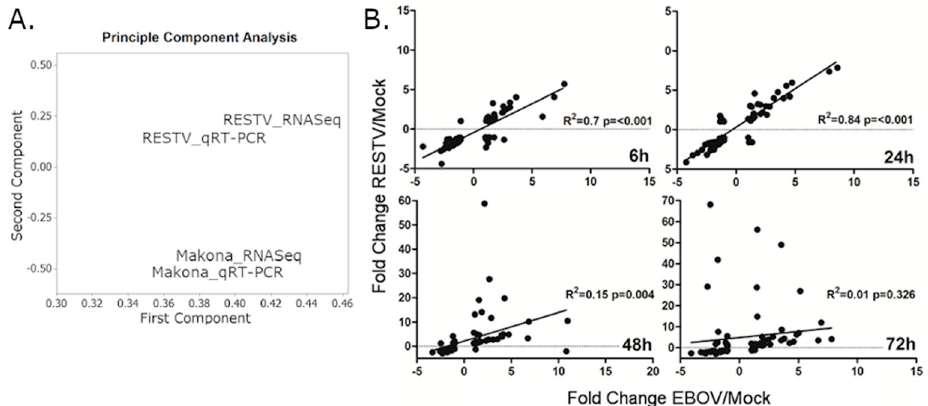
Figure 2. ( A ) Principle component analysis of combined 24, 48, and 72 h data for RNA-Seq and qRT-PCR data, only including RNA-Seq data for transcripts present in qRT-PCR analysis. ( B ) Spearman analysis of the correlation between qRT-PCR data obtained from differentiated THP-1 cells infected with RESTV or EBOV at 6, 24, 48, or 72 h. R 2 values were given to indicate correlation. An R 2 value of 1 indicated a perfect correlation, and 0 indicated no correlation. Significance testing was performed by Spearman’s correlation without correction, where a p -value of < 0.05 was likely to be a significant test of correlation. All transcript targets in the qRT-PCR arrays were utilised in this analysis. X axes show fold change in qRT-PCR delta-cT values for EBOV-infected THP-1 cells. Y axes show fold change in qRT-PCR delta-cT values for RESTV-infected THP-1 cells. All data described in this figure were produced from experiments conducted using triplicate